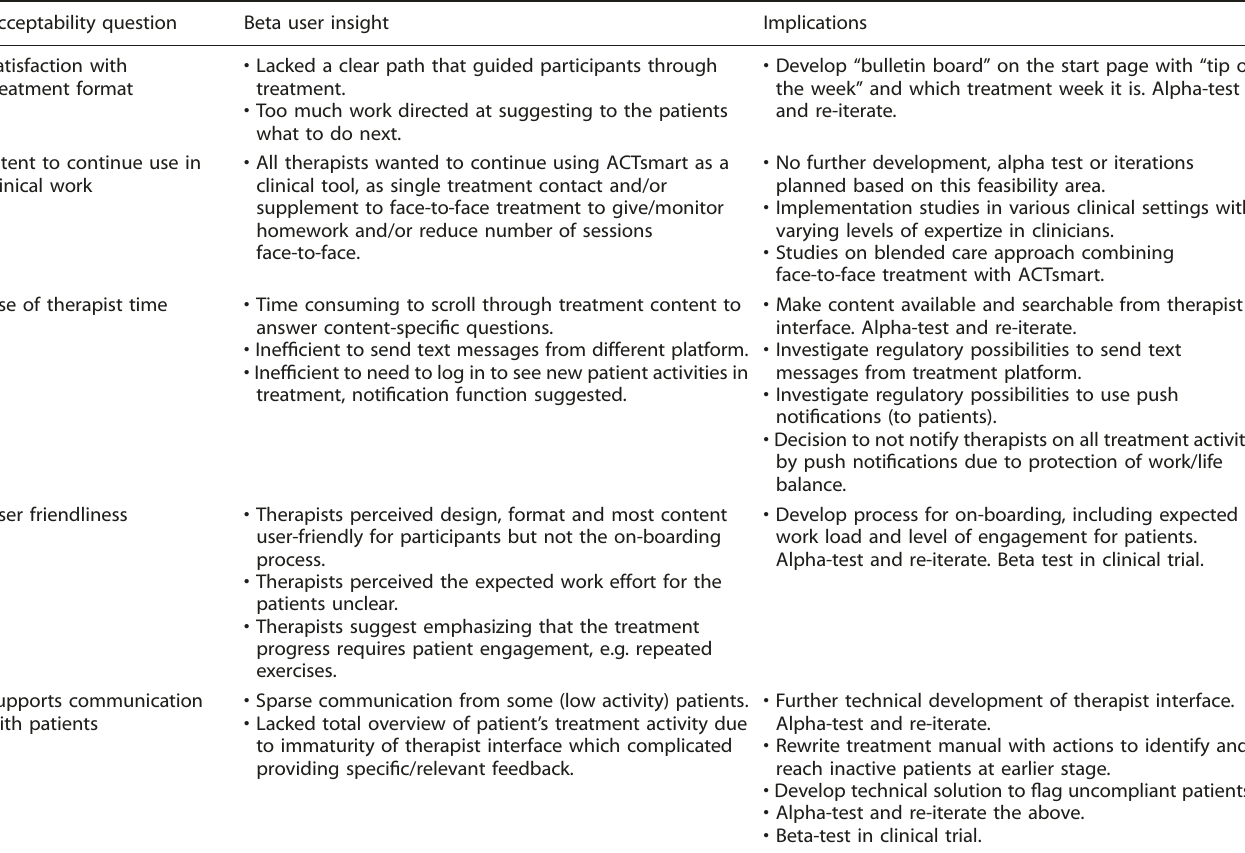
Table 2. Key therapist end-user insights with implications from UX-interviews post beta testing. Acceptability question Beta user insight Implications Satisfaction with treatment format